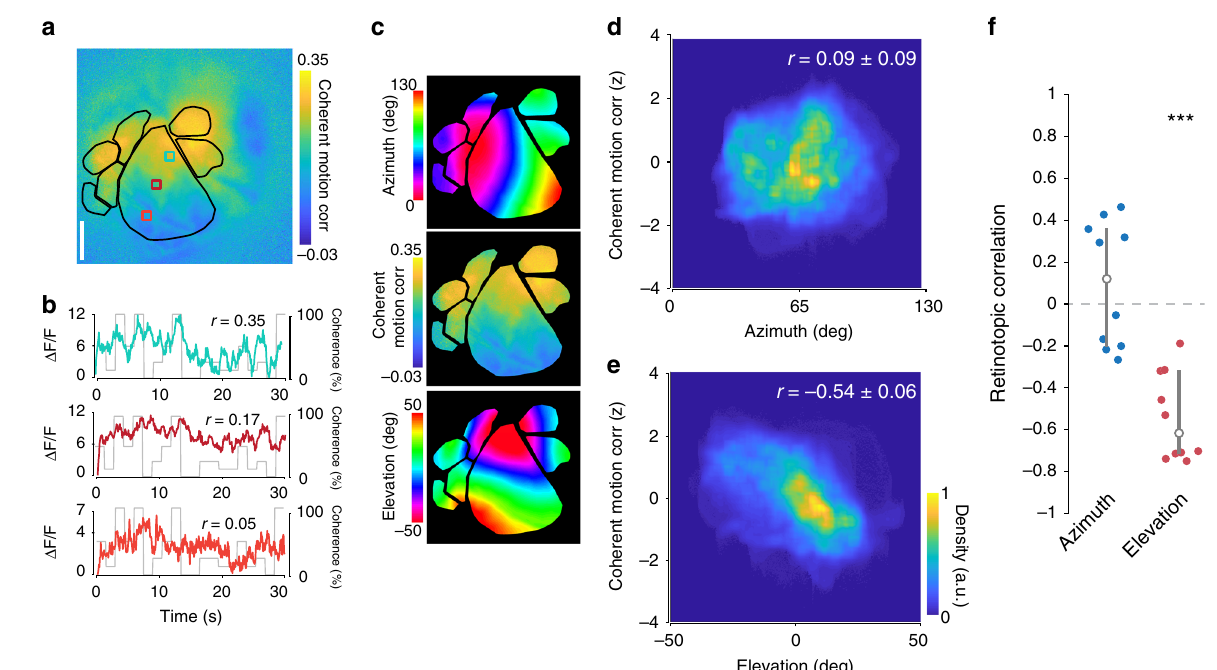
Fig. 4 Retinotopic asymmetry of coherent motion correlations across the visual cortex. a Map from single experiment showing gradient of coherent motion correlation along the vertical retinotopic axis of V1. b Single pixel responses from anterior (blue, r = 0.35), middle (red, r = 0.17), and posterior (orange, r = 0.05) pixels in V1, showing different amounts of coherent motion correlation. c Visual cortex isolated maps from mouse in ( a ) of azimuth (top) and elevation (bottom), as well as the coherent motion correlation (middle) for comparison. d Density scatter plot across all mice ( n = 10 sessions over 10 mice), showing no signi fi cant correlation to azimuth ( r = 0.09 ± 0.09). Coherent motion correlation is z -scored to account for differences between experiments. e Same as ( d ), but for elevation, showing a signi fi cant negative correlation between elevation preference and coherent motion correlation across visual cortex ( r = − 0.54 ± 0.06, p = 1.9 × 10 − 5 , two-tailed single-sample t test). f Comparison of retinotopic correlation between azimuth and elevation. There is a signi fi cant anticorrelation of coherent motion correlation and elevation across mice, but none with azimuth ( p = 1.9 × 10 − 5 , two-tailed single-sample t test. Error bars are median ± quartiles (*** p <